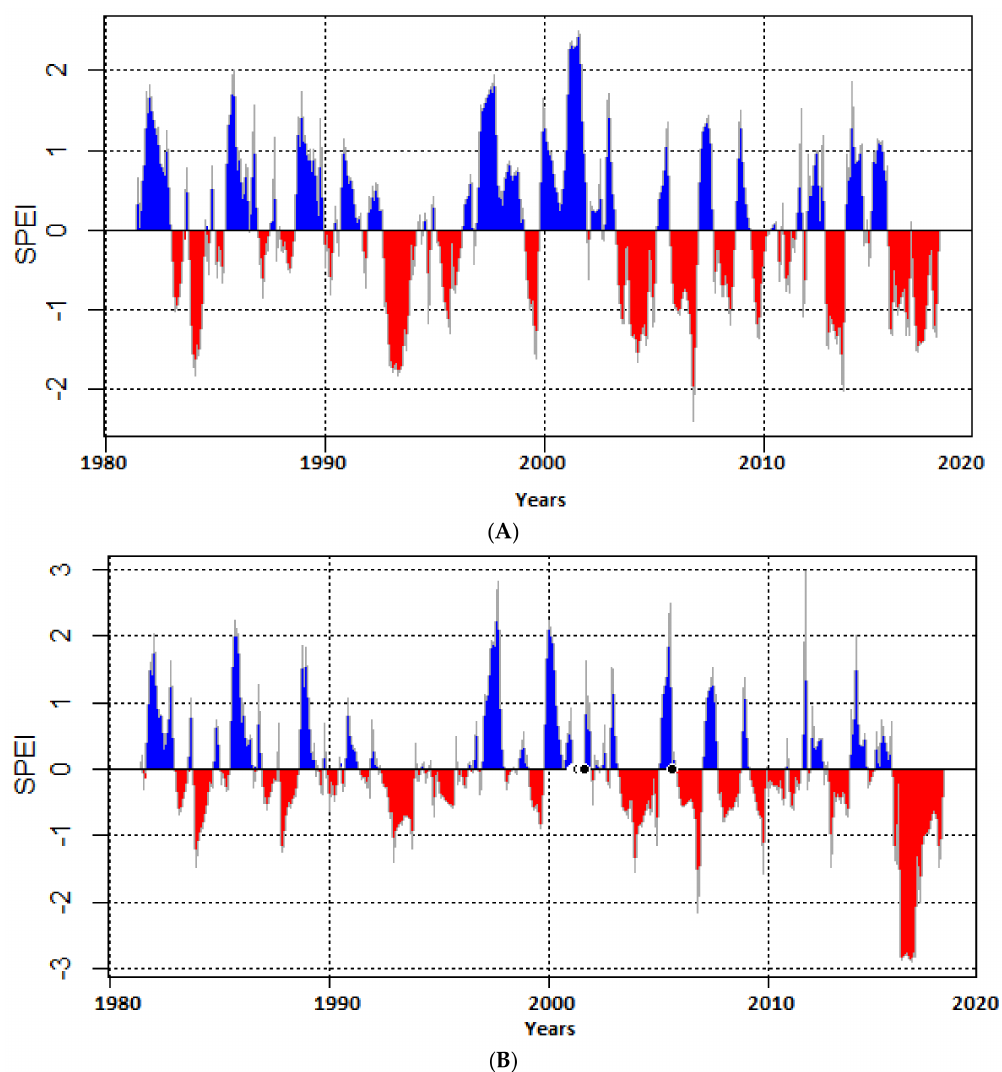
Figure 5. ( A ) SPEI 6 for western bushveld and ( B ) and SPEI 6 for the eastern lowveld. In 1993/94 both sides of the district experienced moderate drought, but 1997/98 was a severe drought on the western bushveld while it was a mild drought on eastern lowveld. The season 2002/2003 came with severe drought conditions for the entire district. The first extreme occurred during 2004/05 season in the western bushveld, whereas the eastern lowveld experienced its first extreme in (2007/8) season. About 23 years later after the 1991/92 drought season, South Africa experienced one of the worst droughts ever during the 2015/16 season [7]. This was recorded as a prolonged drought season as the rising temperatures coupled from 2014/2015 drought season which was moderate on the western bushveld and extreme on the eastern lowveld. The 2015/16 drought was extreme in the eastern lowveld and severe in the western bushveld of Mopani District Municipality. The general trend over the years shows an increase in magnitude of drought from the eastern lowveld towards the western bushveld. The western bushveld, which is normally wet, shows more decline in precipitation due to drought, as compared to the arid eastern